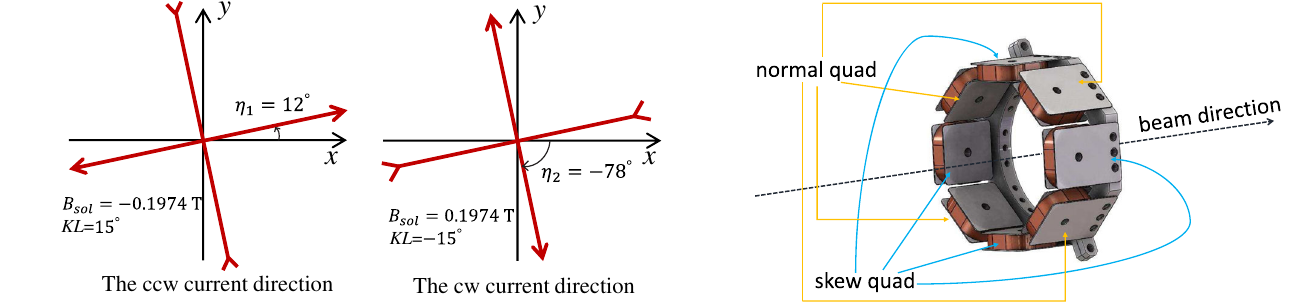
FIG. 12. The mechanical design of the quadrupole corrector at AWA.